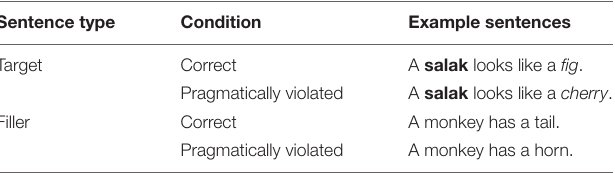
randomly administered to 150 respondents (87 females and